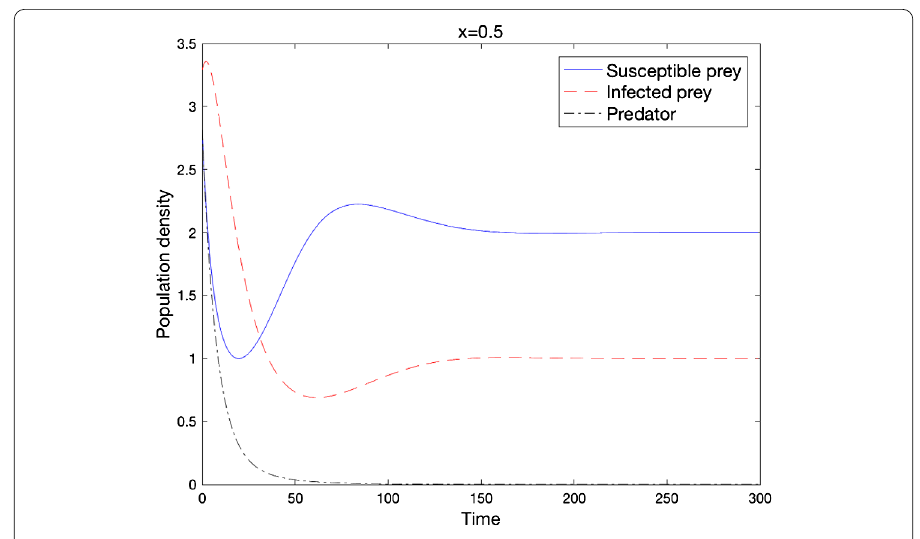
Figure 4 Local stability of e 3 when the condition of Theorem 2.10 holds ( d = 0.01, D = 0.01, r = 1.5, b = 0.5, d 1 = 1.0, d 2 = 2.0, K = 3.0, α = 1.5, β = α , c = 1.0, m =